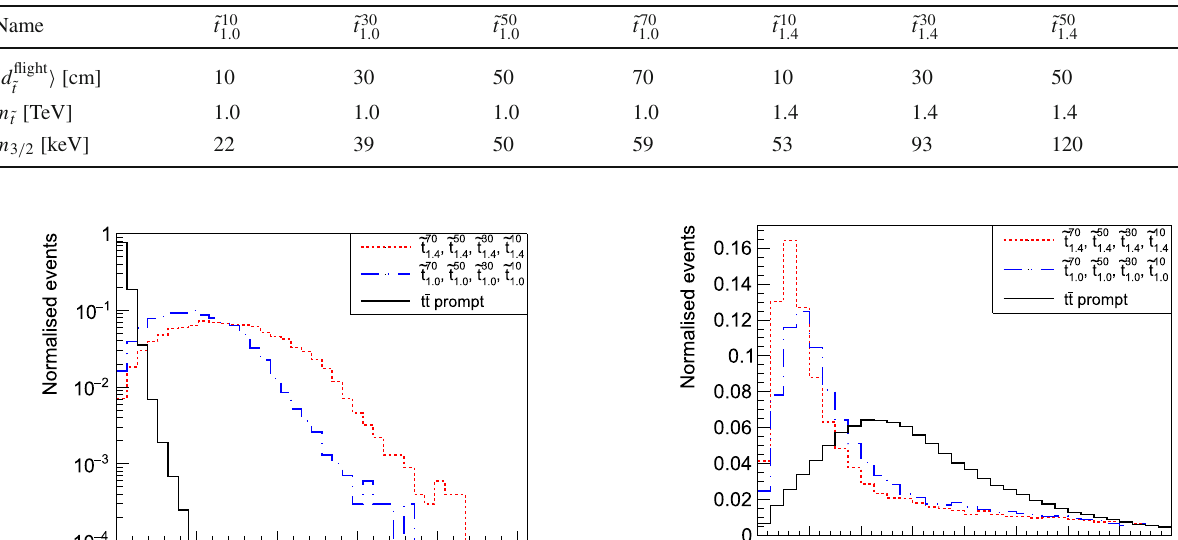
Table 5 Definition of the eight benchmarks for the stop squark pair production pp → ˜ t